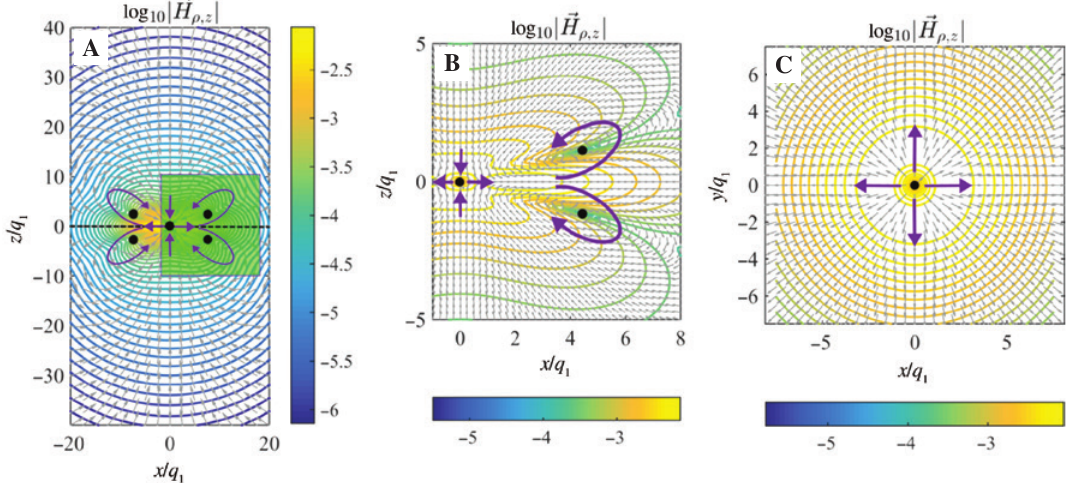
Figure 5: Magnetic field topology of the 1½-cycle TE FD pulse at focus. (A, B) Isoline and arrow plot of the logarithm of the magnetic field in the xz plane. Black dots indicate the zeros of the magnetic field. Panel (B) presents a zoom-in of the area highlighted by green in (A). The dashed line in (A) marks the z = 0 level of the cross-sections presented in (C). (C) Isoline and arrow plot of the logarithm of the magnetic field in the xy plane at z = 0 (dashed line in (A)). The black dot corresponds to the zeros of the magnetic field. Purple arrows in all panels mark the direction of the magnetic field and serve as guide to the eye. The pulse is at focus ( t = 0) and propagates along the positive z